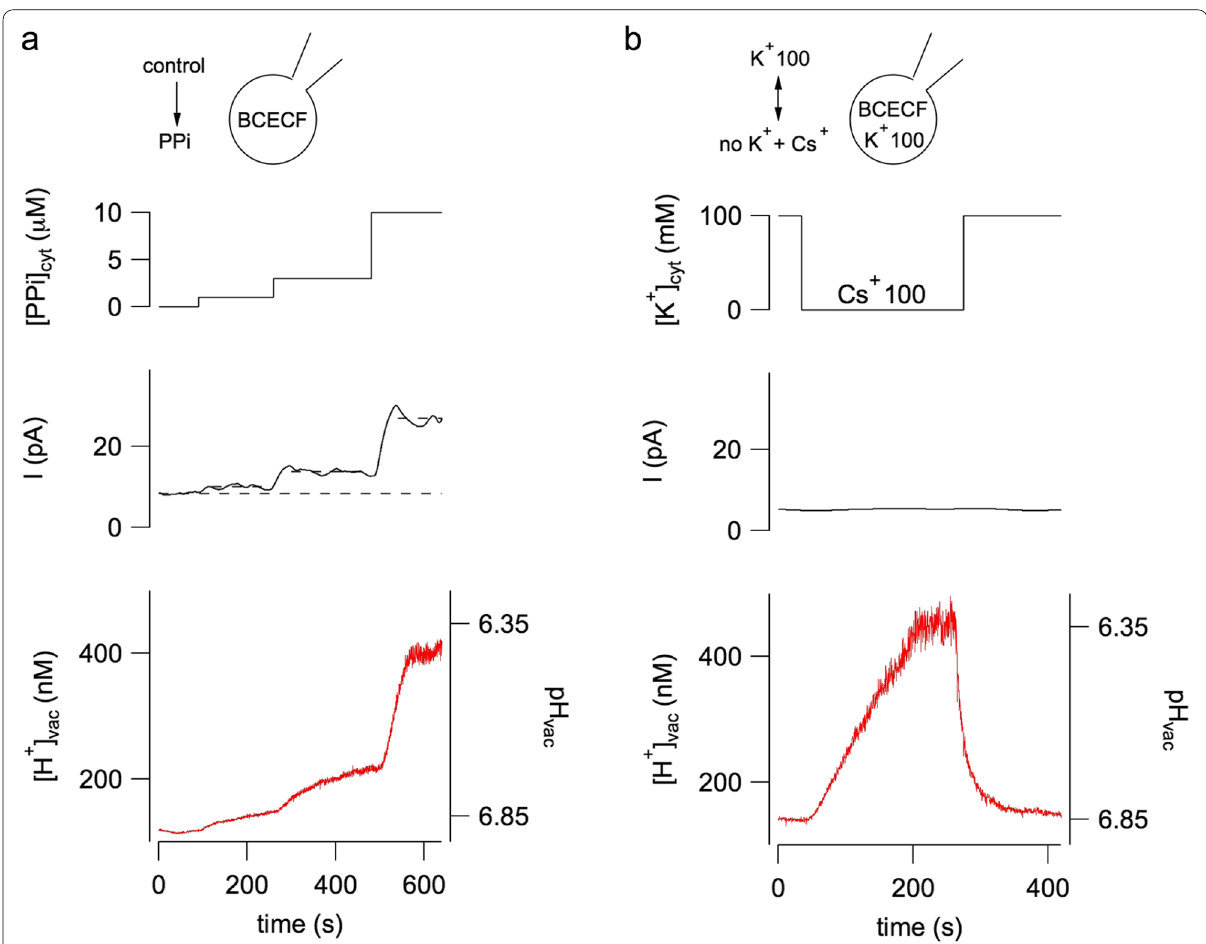
Fig. 6 Vacuolar acidification revealed by the proton-sensitive fluorescent dye BCECF. a Inorganic pyrophosphate (PPi) is added to the bath solution (top panel) at concentrations of 1, 3 and 10 μM (dotted lines indicate that the switching of the bath solution is irrespective to the real change due to the perfusion system, see Gradogna et al. 2021 for a discussion about the effects of the perfusion). Middle panel shows the correspondent time course of tonoplast membrane current due to vacuolar proton-pumping pyrophosphatase activation. Bis(2-carboxyethyl)-5(6)-carboxyfluorescein (BCECF) loaded inside the vacuole through the patch pipette allows the determination of luminal proton concentration changes (bottom panel). b Substitution of cytosolic bath solution potassium with an equimolar amount of caesium ions is schematically displayed in the top panel. The middle panel shows that there is no change in background current (holding voltage of 0 mV). However a significant acidification of the luminal solution is apparent (bottom panel). Modification of Fig. 1, from Gradogna et al. (2021), New Phytologist, 229:3026–3036, reprinted by permission from